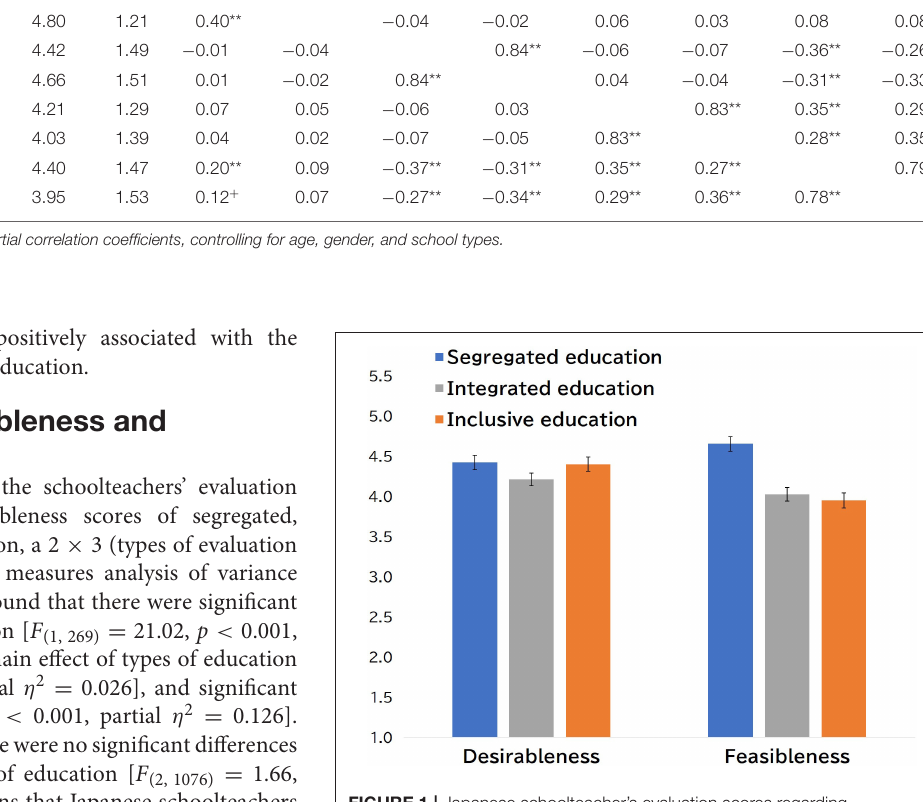
FIGURE 1 | Japanese schoolteacher’s evaluation scores regarding segregated, integrated, and inclusive